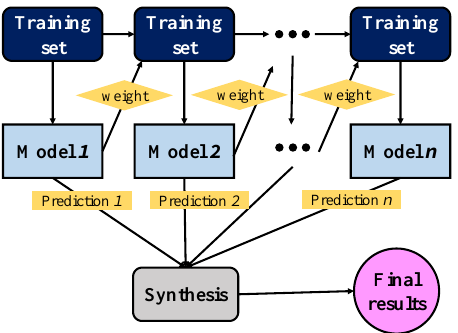
Figure 2. AdaBoost algorithm calculation process.